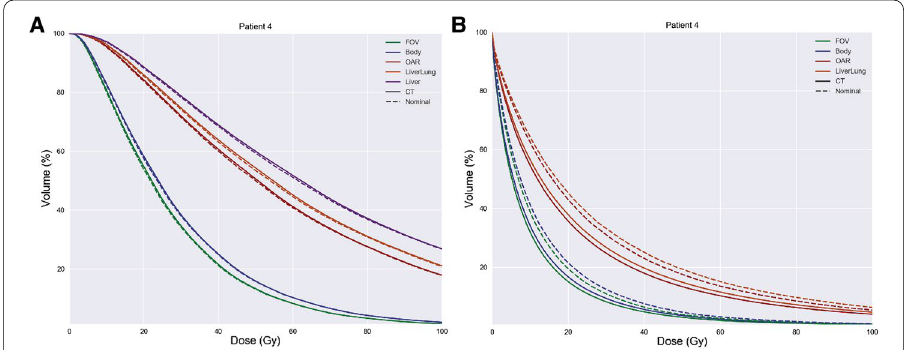
Fig. 2 Liver ( A ) and lung ( B ) cumulative dose volume histograms (DVHs) are shown for one patient.